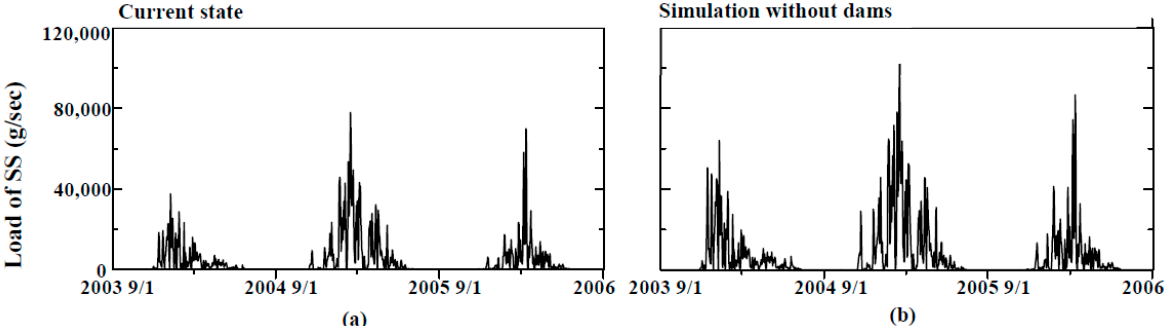
state ( b ) the simulation without the dams.